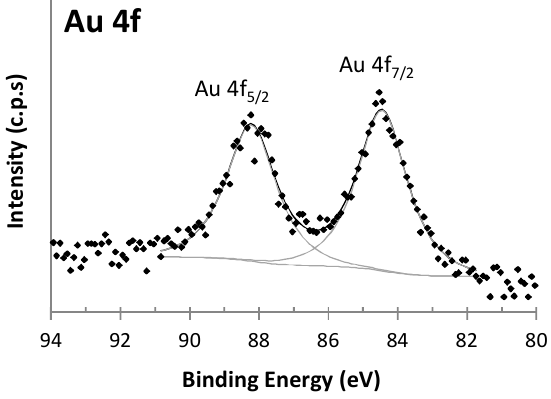
Figure 2. X-ray photoelectron spectroscopy (XPS) Au 4f region for the AuNPs 1% tea.